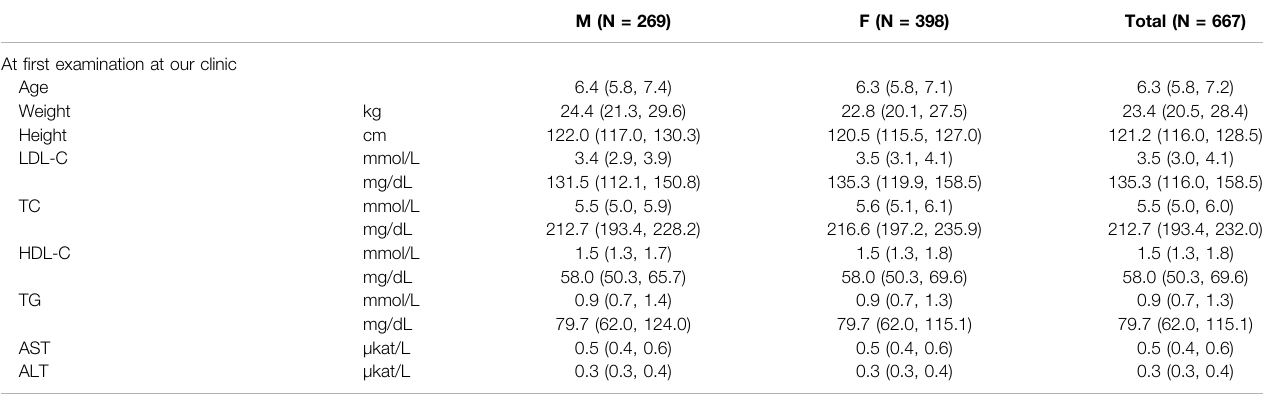
TABLE 1 | Demographical data of the children included in the study.